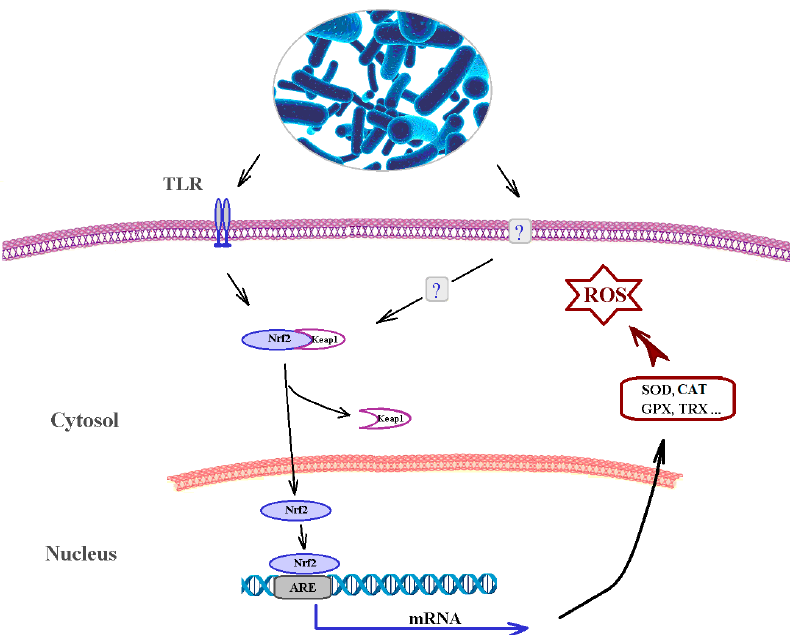
Figure 2. Effects of lactobacilli and bifidobacteria on cellular receptors and regulation of internal signal transduction systems of eukaryotic cells. ?: identified but undefined receptors and signaling molecules